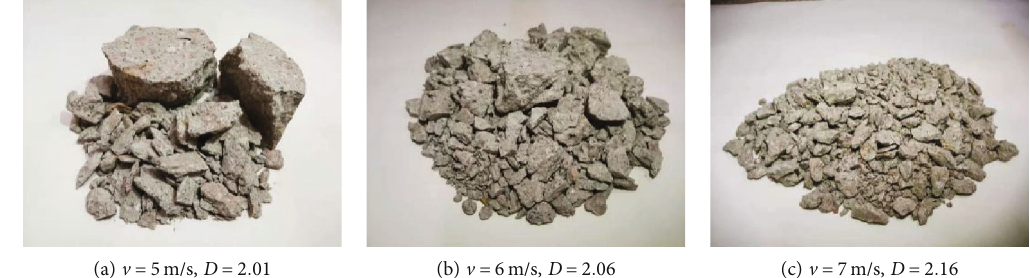
Figure 6: Concrete failure morphology at di ff erent impact speeds.